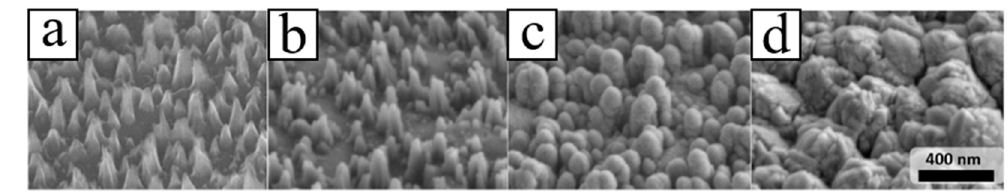
16 of 24 Figure 19. Schematic illustration for composite TiO 2 NTs/BDD electrode. Cyclic voltammetry plots: ( a ) combination electrodes TiO 2 NTs/BDD-10 k, with pure TiO 2 and BDD immersed in 0.1 M NaNO 3 ( ν = 50 mV/s), ( b ) the curve of peak currents versus the square root of the scan rate for dif- ferent BDD-covered electrodes [70,105,106]. Most recently, Miroslav et al. [41] reported on the development of a unique photoe- lectrochemical electrode consisting of a nanostructured BDD layer covering an n-type TiO 2 film (Figure 20). The effects of the nanostructure, B doping level and TiO 2 film thick- ness on the properties of PEC were studied. Using RF magnetron sputtering, the BDD films with two doping levels (gas phase B/C = 1000 ppm and 10,000 ppm) that had already grown and plasma-nanostructured were used as the substrates to deposit TiO 2 layers of 20, 100 and 500 nm. BDD was used as the structure electrode. When the gas phase B/C ratio was 1000 ppm, the surface was covered with a TiO 2 layer 500 nm thick, and the pho- tocurrent was the highest (60 μ A/cm 2 and 3.2 mA/cm 2 at 0 and 2 V vs. Ag/AgCl respec- tively). The favorable influence of the nanostructure type and pn junction on the hole in- jection was confirmed by experiments. Suzuki et al. [37] prepared a mesoporous TiO 2 layer on the BDD and found that deep-UV illumination could improve its photocatalytic effi- ciency. They also used this hybrid electrode in water electrolysis to produce O 3 gas and other reactive oxygen species (ROS). In addition, ROS produced by electrochemistry were